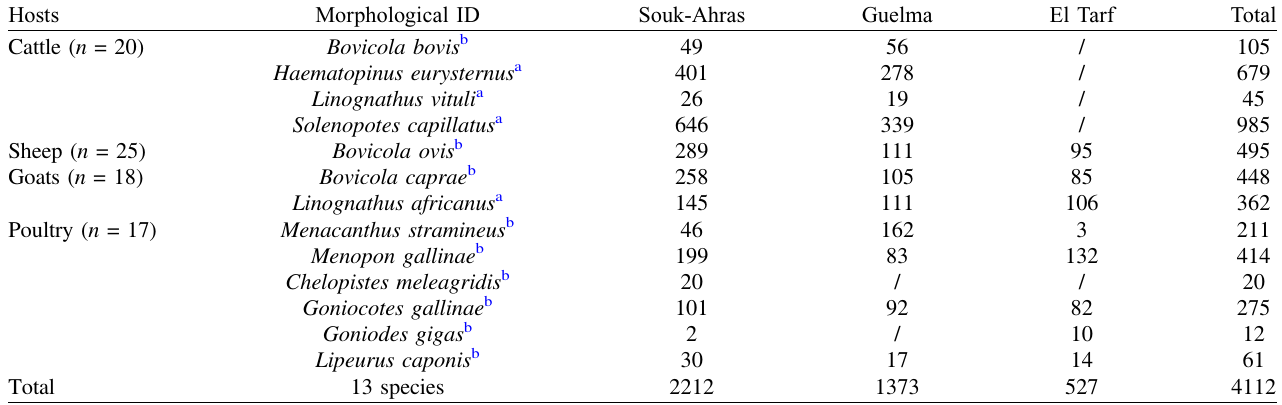
Table 2. Morphological identi fi cation of lice collected from Algeria and stored at (cid:2) 20 (cid:3) C before being tested by MALDI-TOF MS. Hosts Morphological